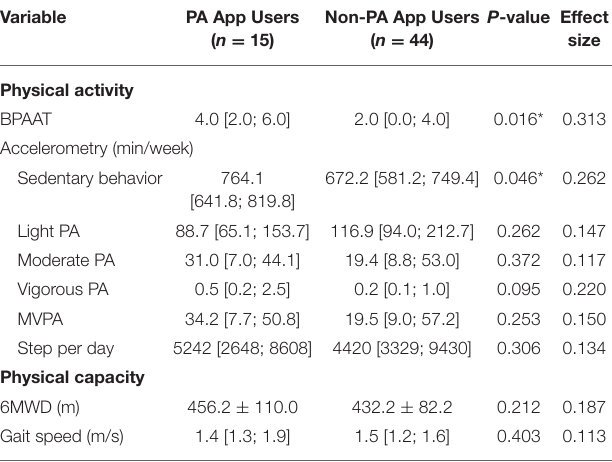
TABLE 3 | Physical activity levels and exercise capacity of PA App Users and Non-PA App Users.